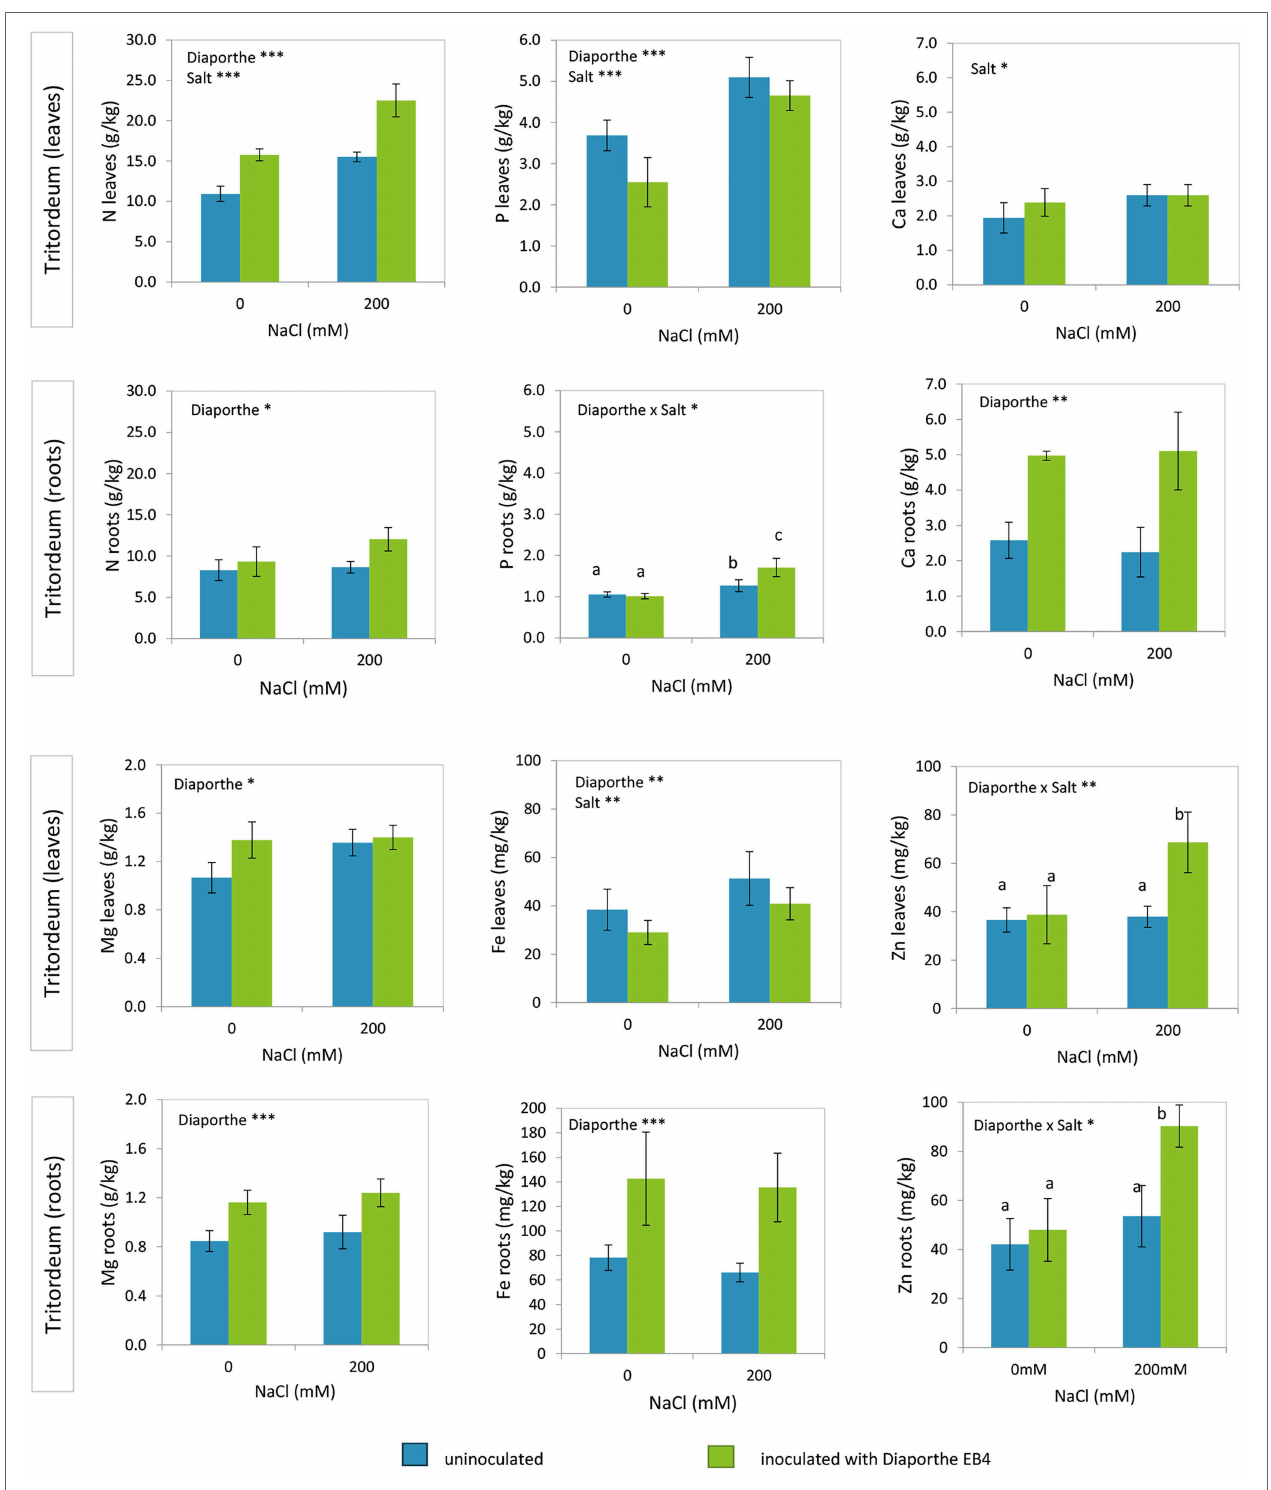
FIGURE 3 | Total nitrogen, phosphorus, calcium, magnesium, iron, and zinc contents in leaves and roots of tritordeum plants not inoculated ( BLUE ) or inoculated with Diaporthe EB4 ( GREEN ), at two different salinity treatments (0 and 200 mM NaCl). Values are means ± SD ( n = 6). When the interaction [ Diaporthe inoculation × salinity] was significant, different means are indicated with different letters (Tukey test p < 0.05). Significant effects of “ Diaporthe inoculation” and/or “salinity” are indicated as * p < 0.05; ** p < 0.01; *** p <